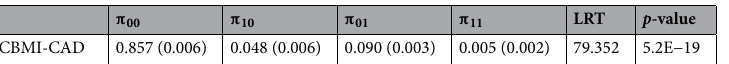
Table 1. Pleiotropy assessed between CBMI and CAD by GPA method. The values in the brackets are standard errors of the estimates. The last two columns provide the LRT statistics and p-values of hypothesis testing. The π 00 represents the proportion of the SNPs not associated with CBMI or CAD; π 10 and π 01 represent the proportion of the SNP associated with CBMI and CAD, respectively; π 11 represents the proportion of the SNP associated with CBMI and CAD.